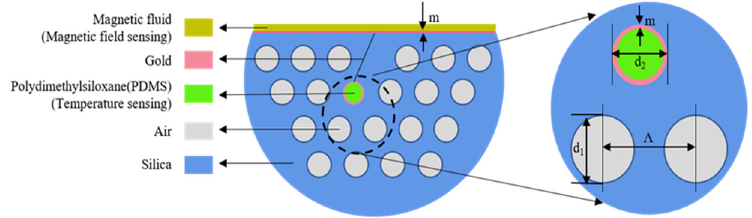
Figure 1. Cross section of the D-type photonic crystal fiber integrated with a gold film, magnetic fluid and PDMS.